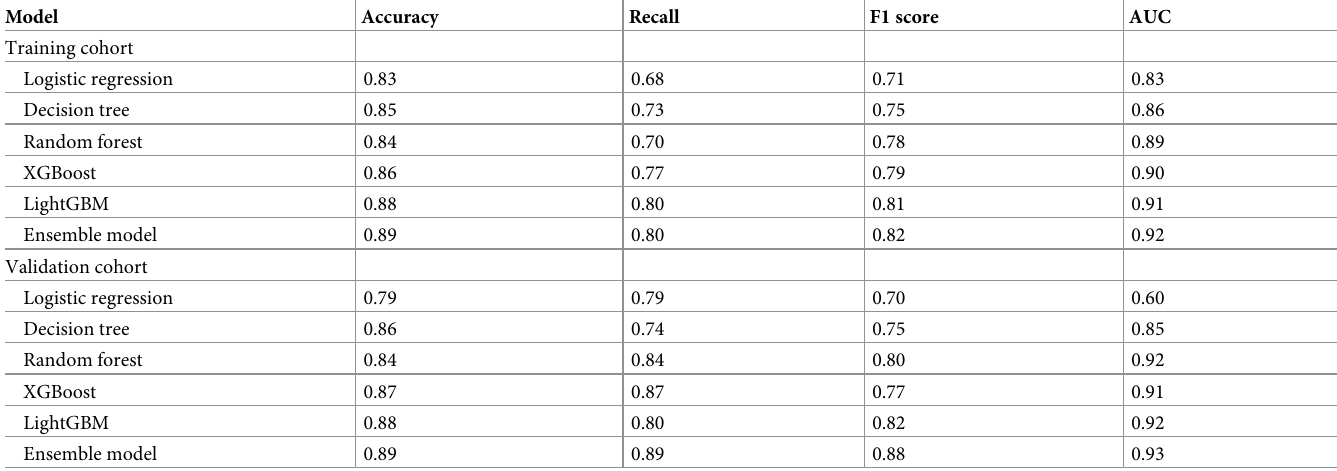
Table 2. Performance of the prediction models using all